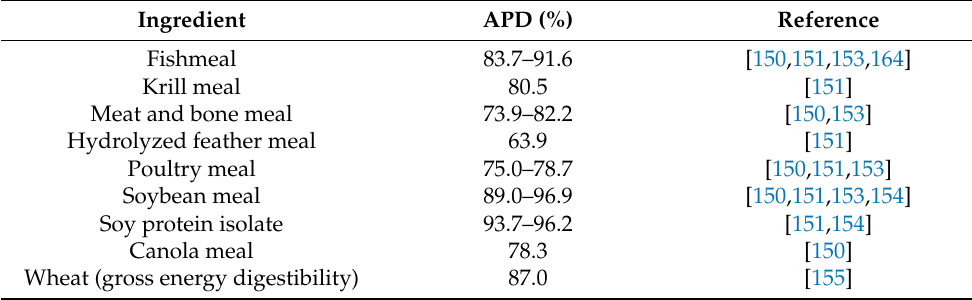
Table 6. Apparent protein digestibility (APD) of ingredients for L. vannamei